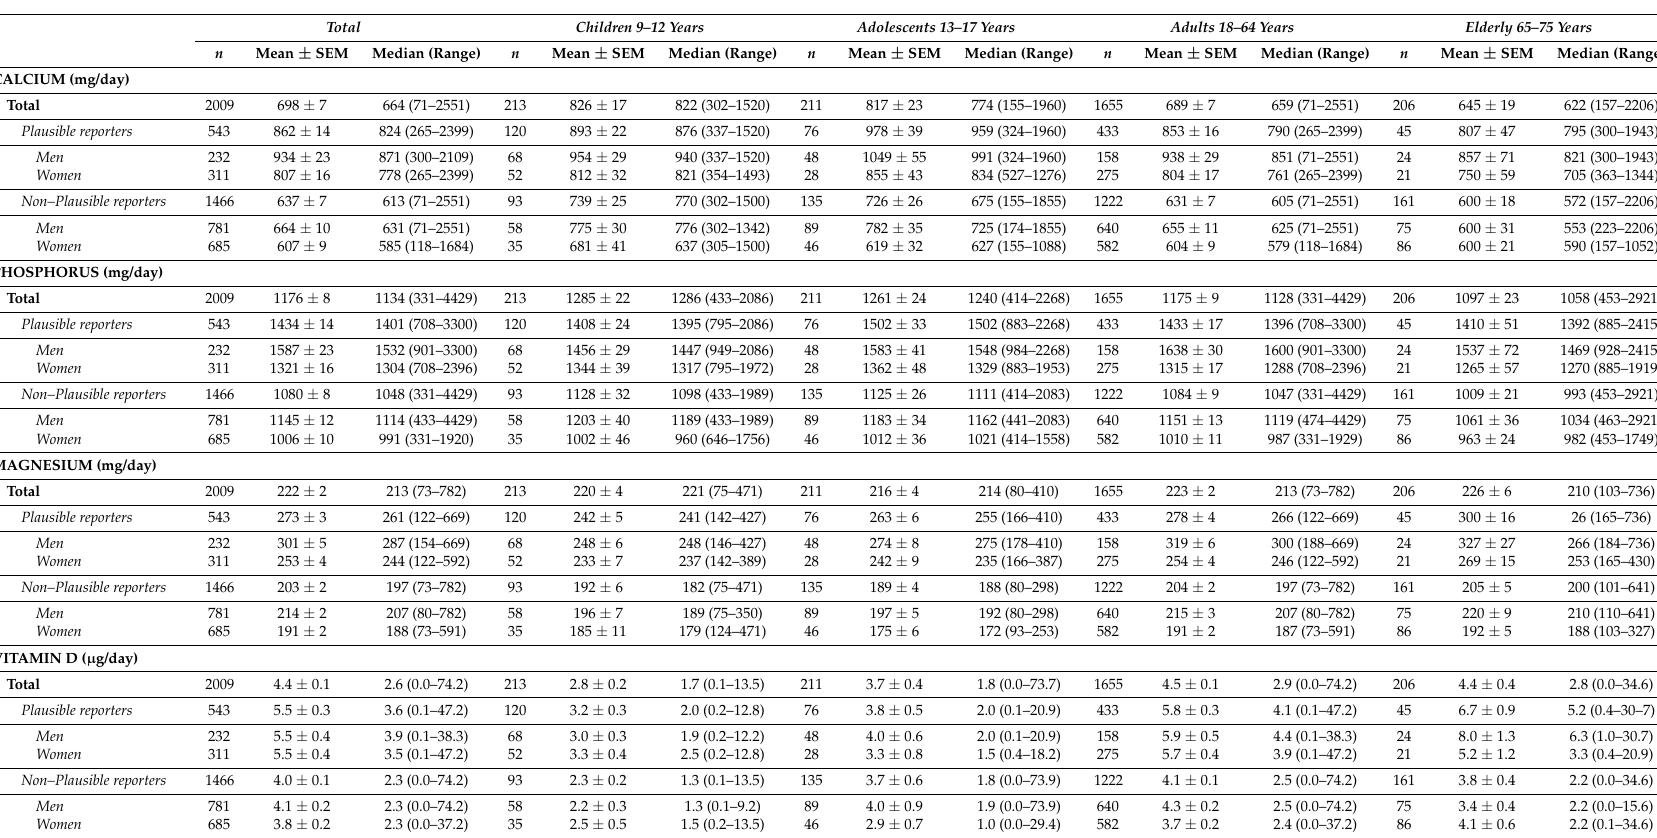
Table 3. Daily calcium, phosphorus, magnesium and vitamin D reported intake by plausible reporters, non-plausible reporters and age group in the ANIBES Study